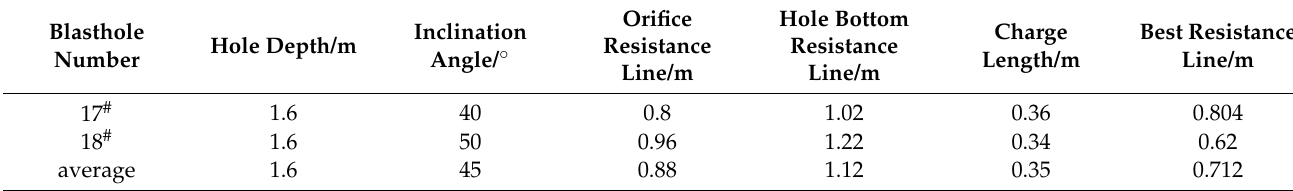
Table 5. Test results of inclined bench blasting